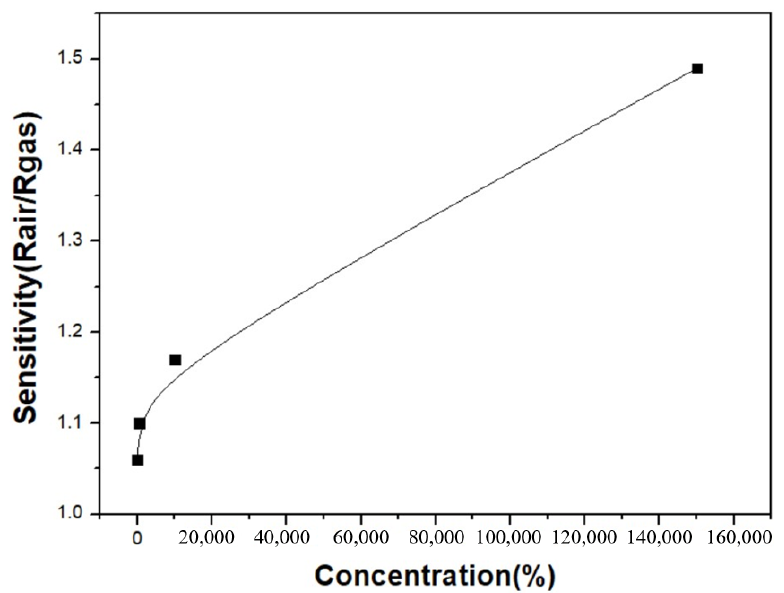
Figure 8. The sensitivity changes in the ZnO/graphene heterojunction sensor versus the variation in the H 2 concentrations at 250 °C.